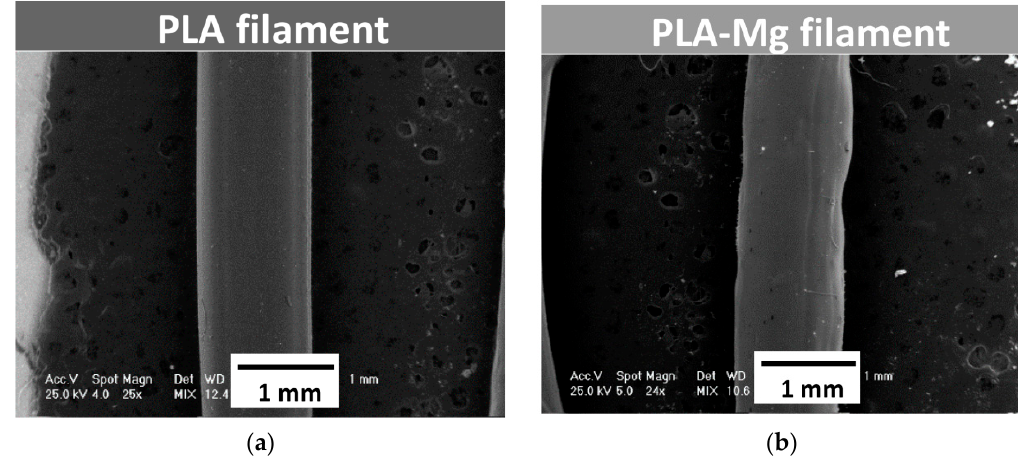
Figure 3. SEM analysis of the experimental filament-general view: ( a ) PLA; ( b ) PLA-Mg in Composition 1 showing the non-homogeneities in diameter due to the presence of Mg particles.